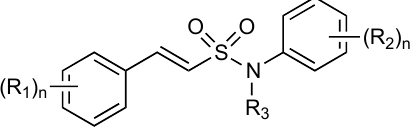
Figure 18. General structure of sulfonamido β-lactamase